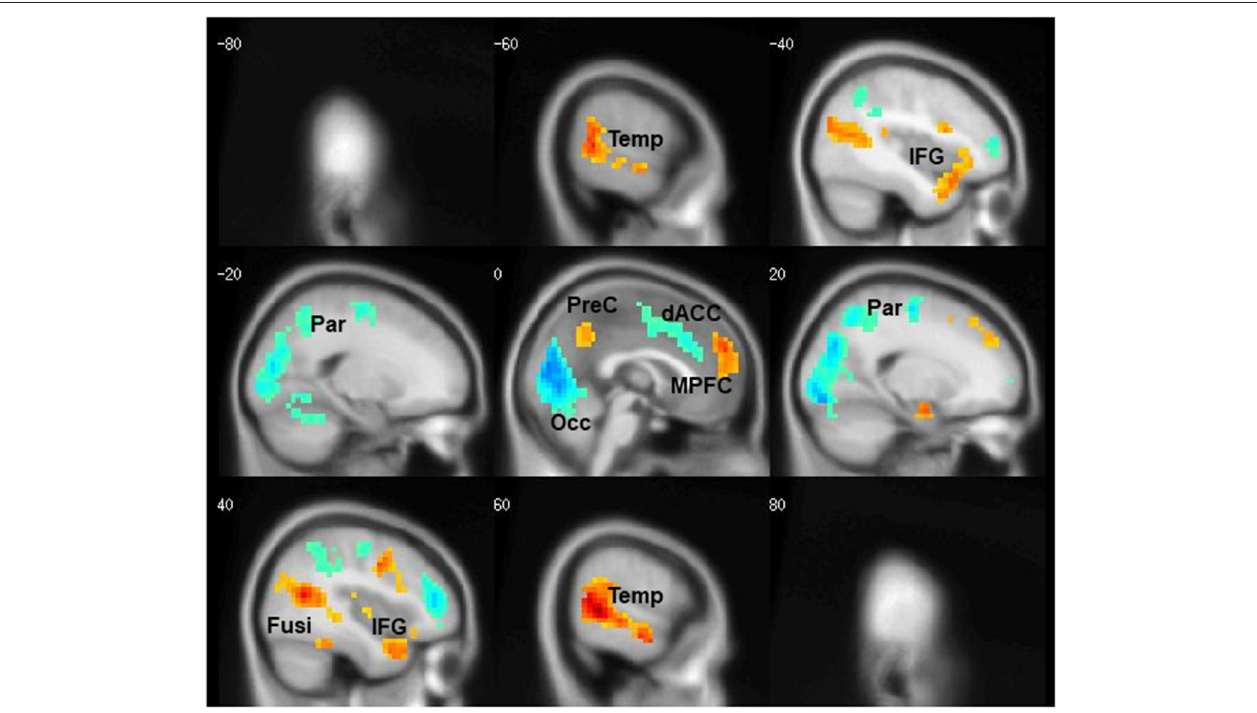
FIGURE 2 | Cortical regions differentially activated by task condition. Areas more active during the People condition are shown in red, areas more active during the Bumper condition are shown in blue.